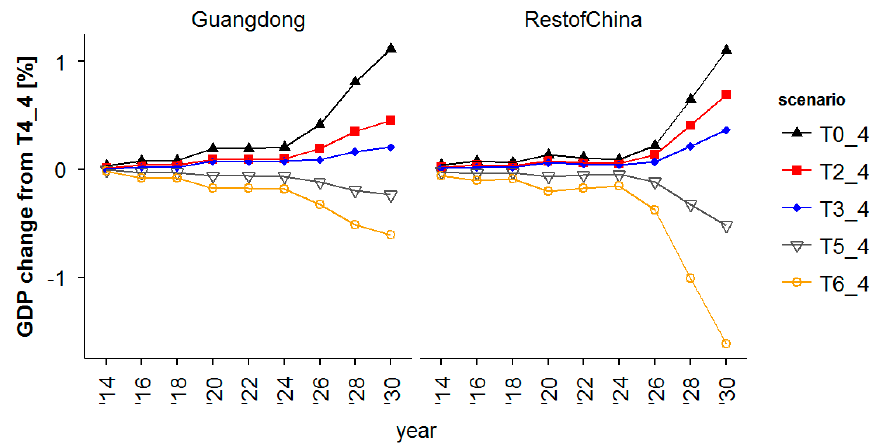
Figure 11. Impacts on GDP under different carbon tax policies compared with T4_4.